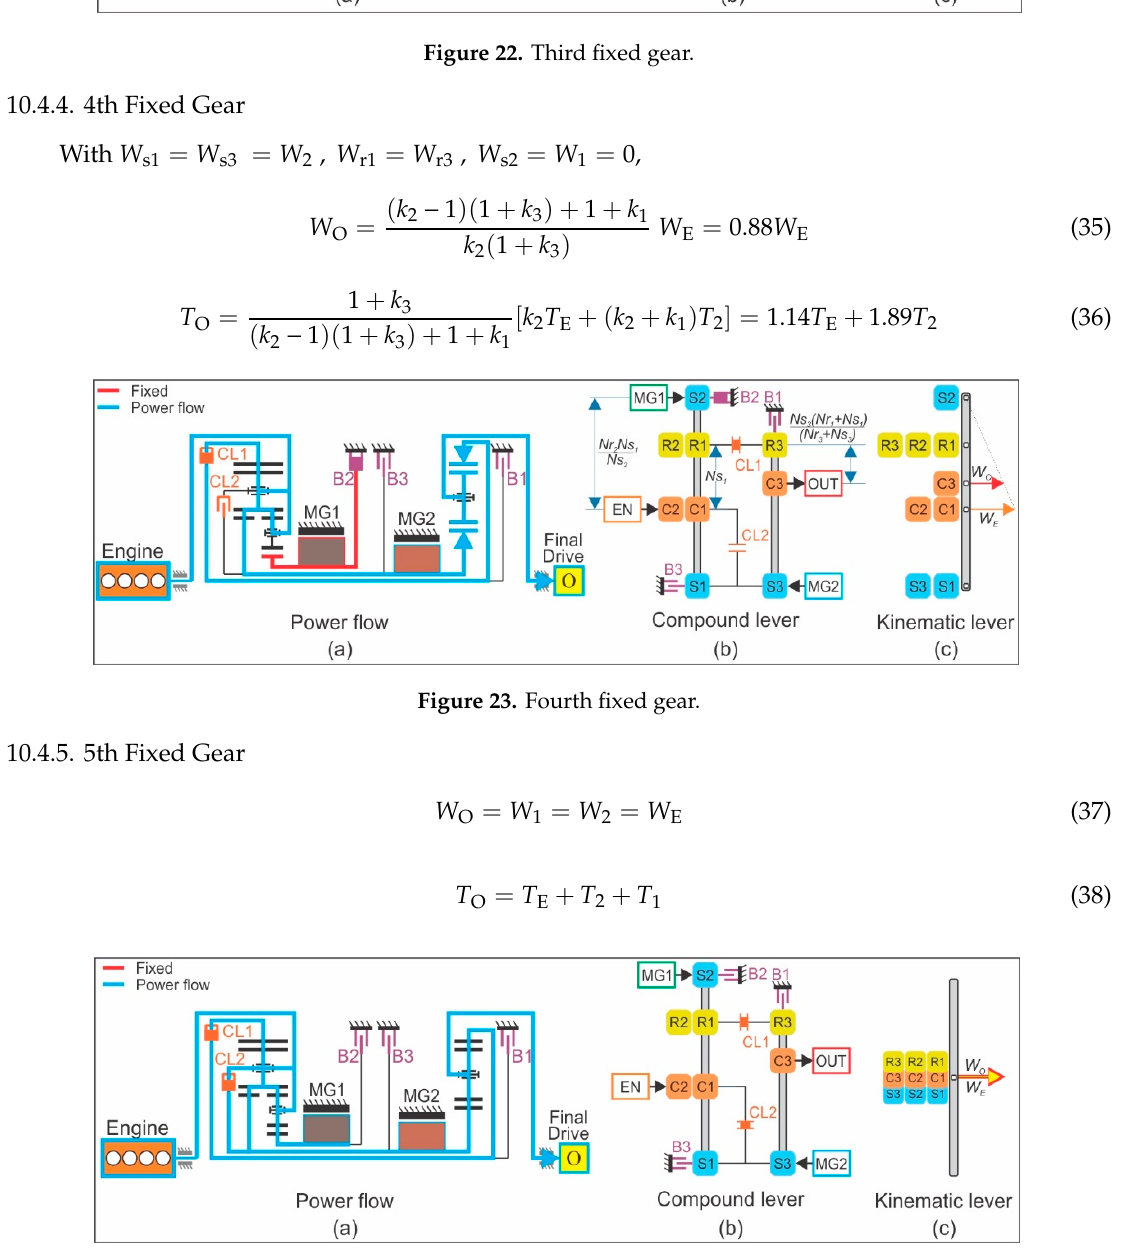
Figure 24. Fifth fixed gear.